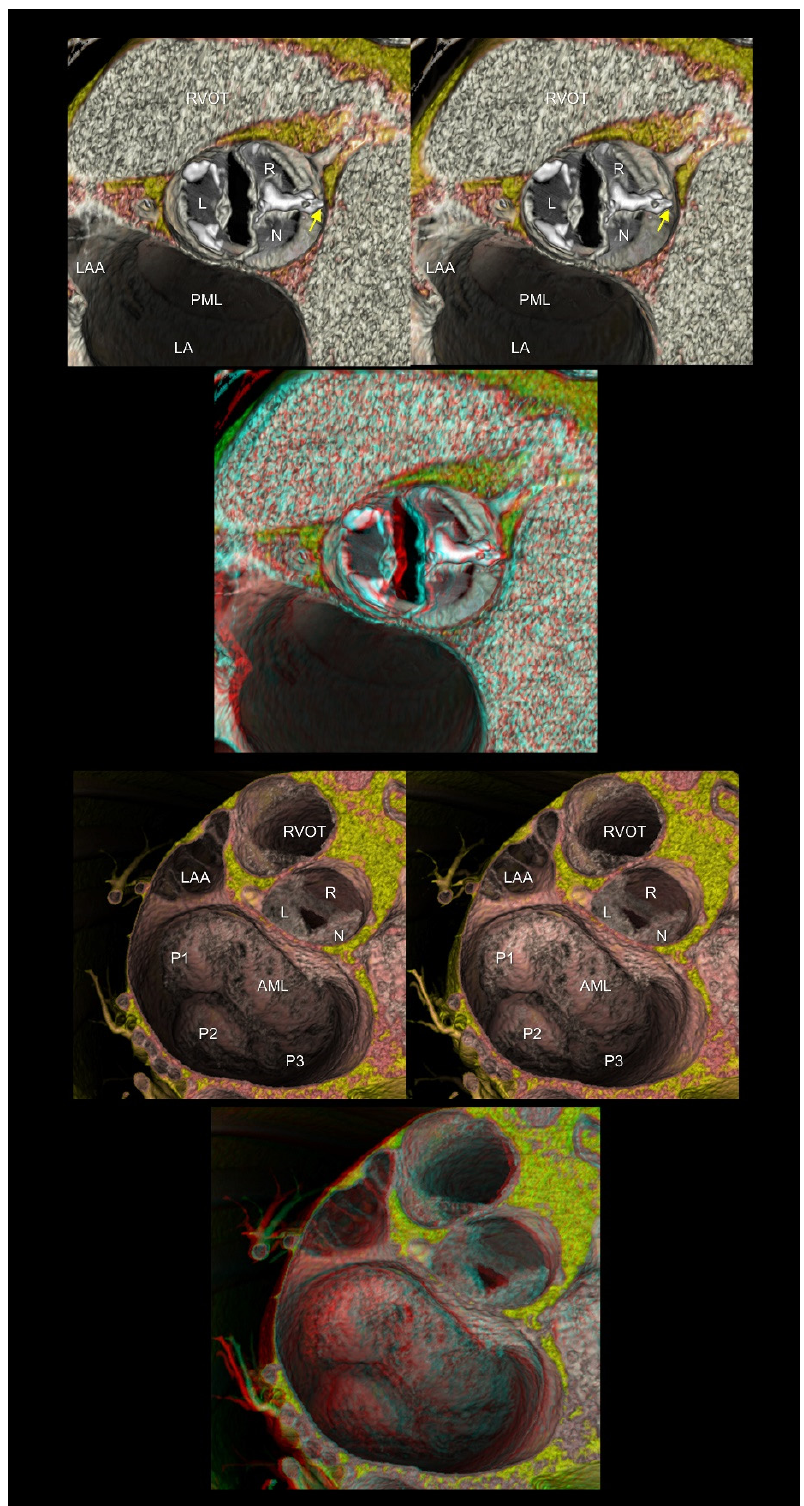
Figure 6. The upper panels show the functionally bileaflet (bicuspid) and trisinuate aortic root. Fusion with the calcified raphe is found between the right and noncoronary aortic leaflets. The apex of the hypoplastic interleaflet triangle between the fused leaflets (yellow arrow) does not reach the plane of the sinutubular junction. The lower panels represent mitral annular dilatation with exten ‐ sive billowing/prolapse of both mitral leaflets, consistent with Barlow’s disease. The first and second panels are aligned for cross ‐ eyed viewing. The third panel is the anaglyph. To see the anaglyph, anaglyphic glasses (red/cyan) are required. AML, anterior mitral leaflet; L, left coronary aortic sinus; LA, left atrium; LAA, left atrial appendage; N, noncoronary aortic sinus; PML, posterior mitral leaf ‐ let; P1, lateral scallop of the PML; P2, middle scallop of the PML; P3, medial scallop of the PML; R, right coronary aortic sinus; RVOT, right ventricular outflow tract.